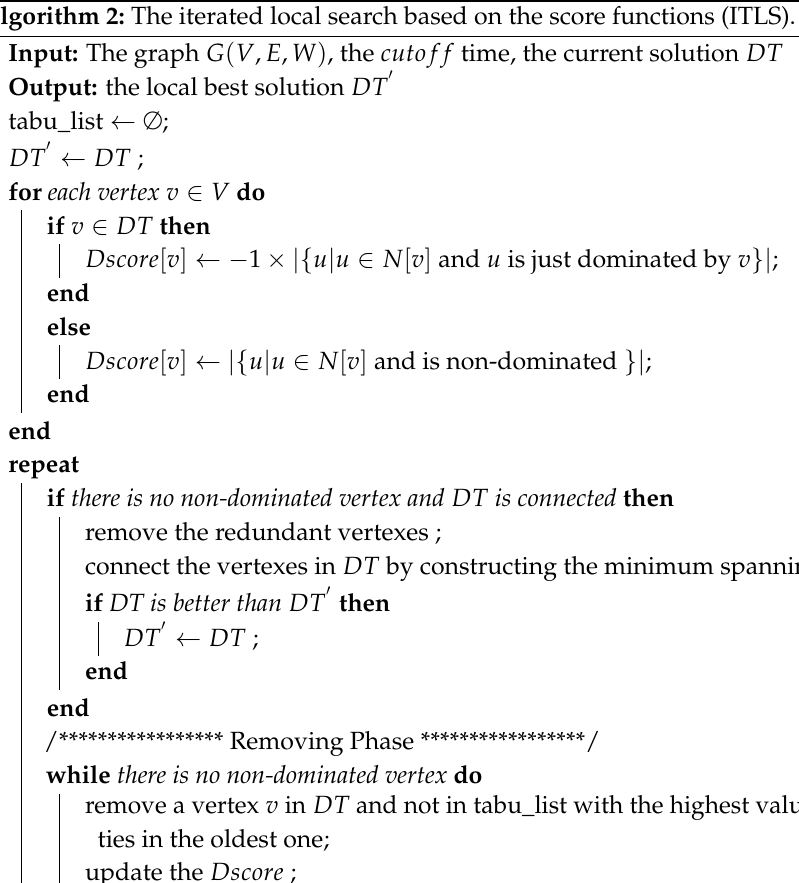
Algorithm 2: The iterated local search based on the score functions